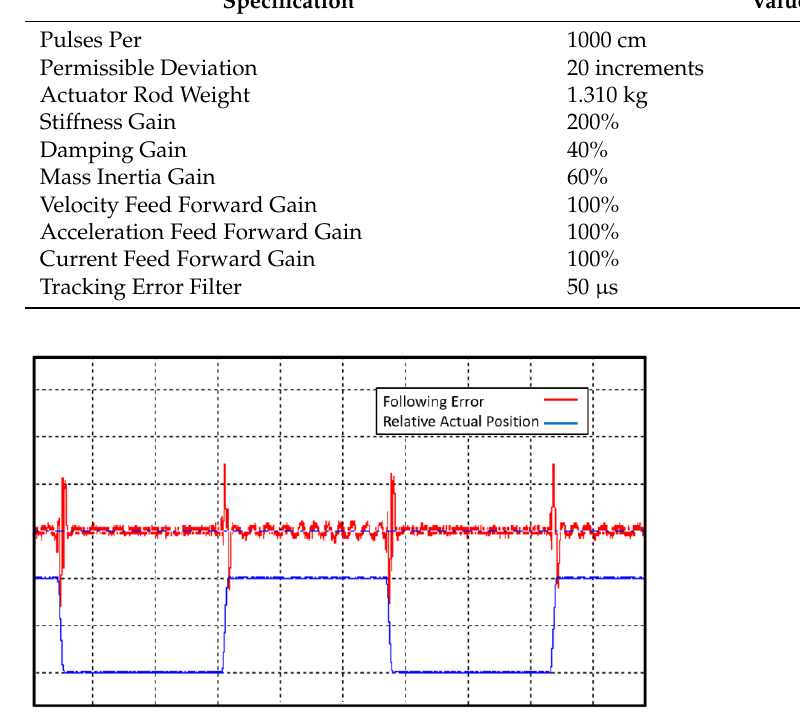
Figure 1. Following error as a function of displacement.